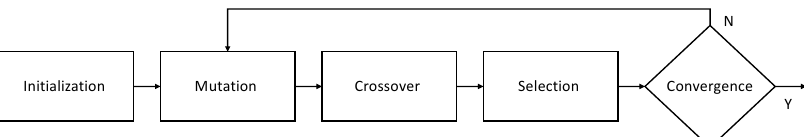
Figure 1. Differential Evolution basic